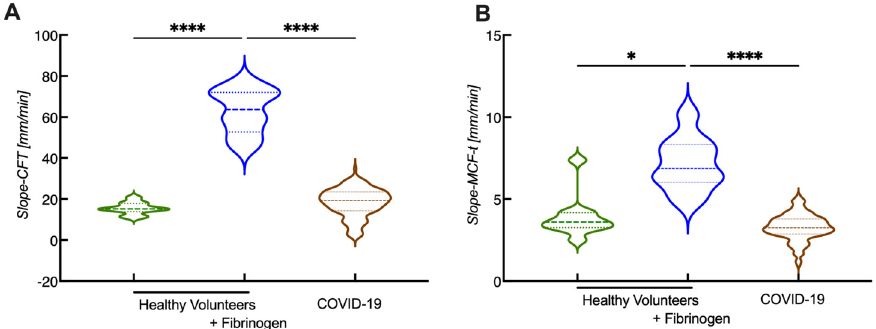
Figure 6. Comparison of slope-CFT and slope-MCF-t in samples from in vitro spiking experiments and in samples from COVID-19 patients. Whole blood samples were obtained from healthy volunteers and spiked with fibrinogen and from COVID-19 patients. (See experimental details in [45,50]) Slope-CFT ( A ) and slope-MCF-t ( B ) are shown. N Healthy volunteers = 10, N COVID-19 = 141, * p < 0.05, **** p <